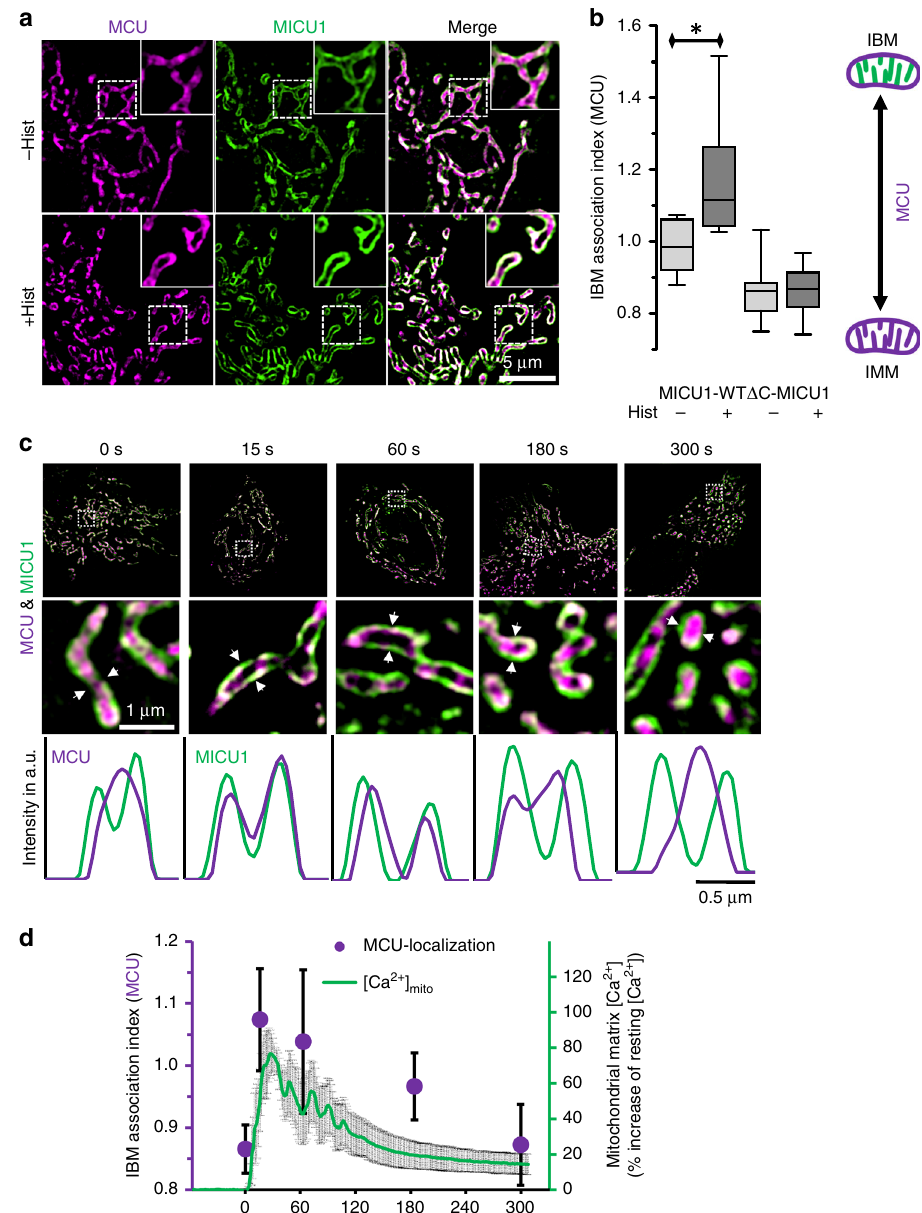
Fig. 6 MCU redistributes with MICU1 correlative to intermembrane Ca 2 + spikes. a HeLa cells were transiently transfected with MCU-mCherry and MICU1- YFP and imaged with SIM under resting conditions ( − Hist) and 90 s after stimulation with histamine (100 µ M) ( + Hist). Representative SIM captures showing the distribution of MCU-mCherry (magenta) and MICU1-YFP (green) are presented. Dotted squares indicate areas shown at high magni fi cation in the upper right corner. b Statistical analysis of the sub-mitochondrial MCU-mCherry distribution in MICU1- or Δ C-MICU1-YFP- expressing cells represented as IBM association index ( n = 8). Horizontal lines represent the median, the lower and upper hinge show respectively fi rst quartile and third quartile, and lower and upper whisker encompass minimal and maximal values. c Representative images (top and middle) and line plots (bottom) of MCU- mCherry (magenta) and MICU1-YFP (green) under resting conditions (0 s) and 15, 60, 180 and 300 s after stimulation with histamine (100 µ M) in nominally Ca 2 + -free buffer. d Time correlation between the accumulation of MCU in the IBM (magenta points) and mitochondrial Ca 2 + concentration (green line and gray error bars) upon stimulation with 100 µ M histamine ( n = 9). Cells were transiently transfected with mito-R-GECO1 to measure mitochondrial matrix Ca 2 + concentrations upon histamine (green line) ( n = 8). Data are shown as mean ± SEM as middle line and whiskers, respectively. * P < 0.05 vs. respective control conditions carried out with unpaired double-sided T -test. Source data are provided as a Source Data fi Δ EF, Δ C-MICU1) that contain the poly-lysine domain (Fig. 2a) power. A potential interaction partner of MICU1 for spatial are located to the IBM while the poly-lysine domain lacking electrostatic interaction might be cardiolipin 25 . Notably, by its MICU1 1 – 70 mutant was found throughout the entire IMM, pKa of 7.5 cardiolipin may facilitate a localization-dependent indicate that sub-mitochondrial localization of MICU1 depends dimorphism of charged head groups separated into the IBM and on the poly-lysine domain and its ability of electrostatic repulsive the CM with a pH of ~7.4 and <7.4, respectively 26,36 . The